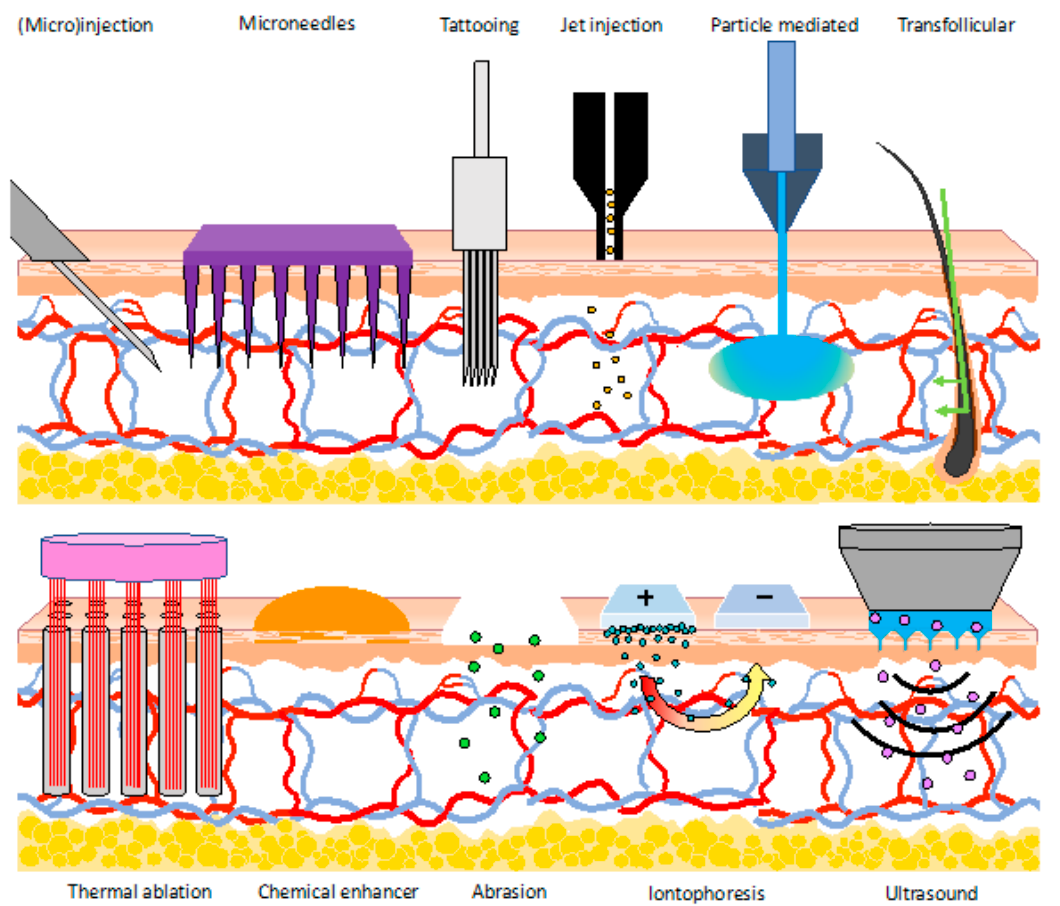
Figure 3. An overview of techniques used for vaccination into the dermal